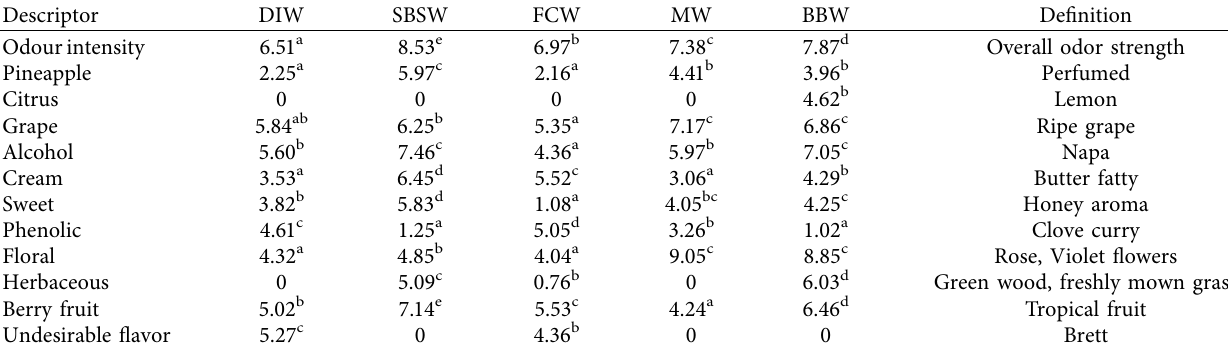
Table 2: Odor descriptors for wines. The mean scores and definition of different